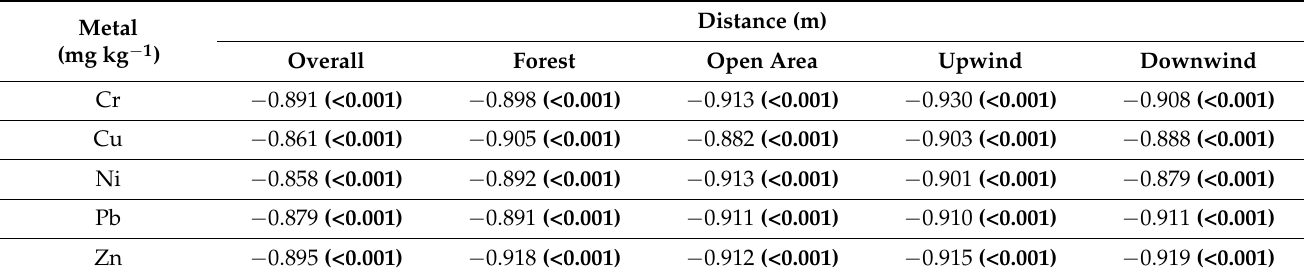
Table 5. Spearman correlation coefficient ( p -Value) N =